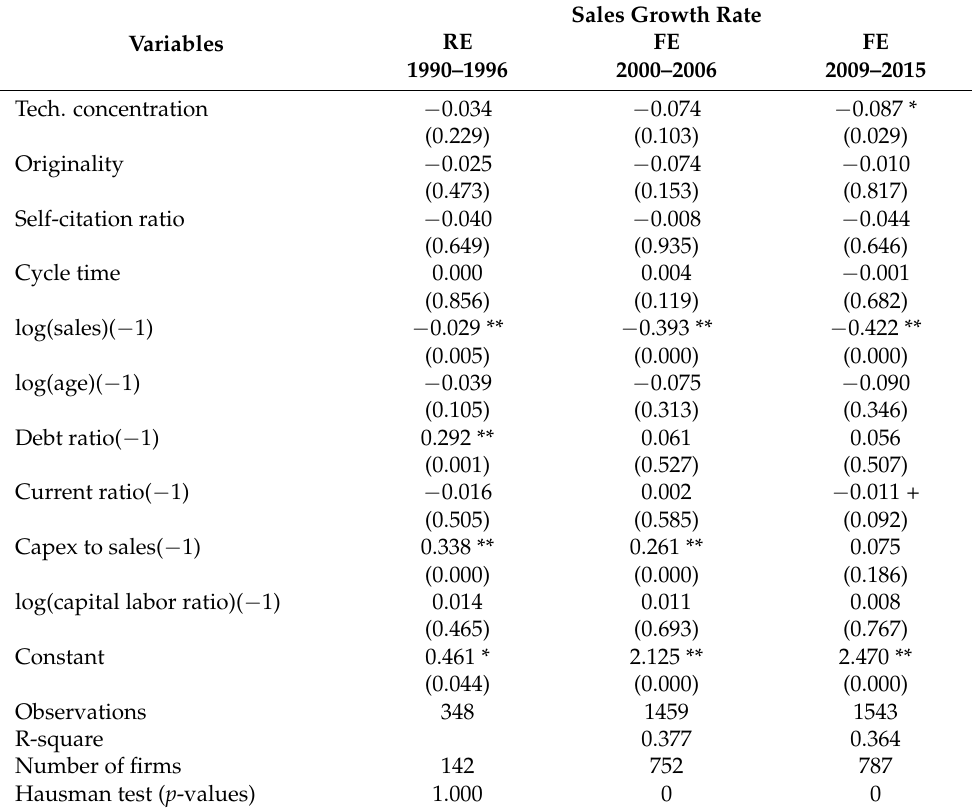
Table 8. Regression results of sales growth rate on innovation